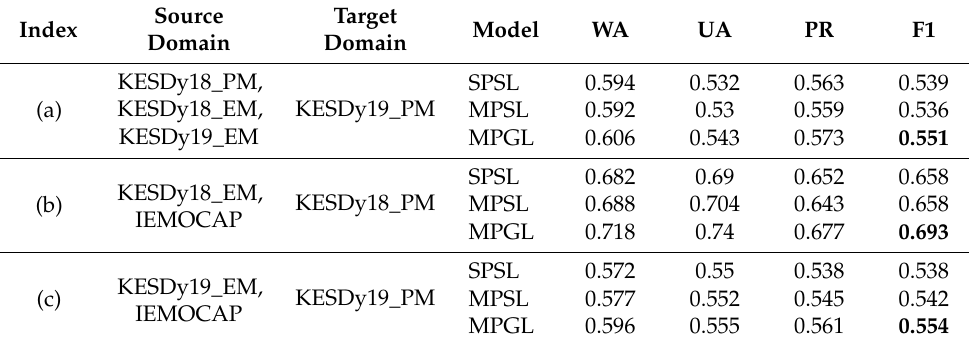
Table 8. Evaluation results of multi-domain